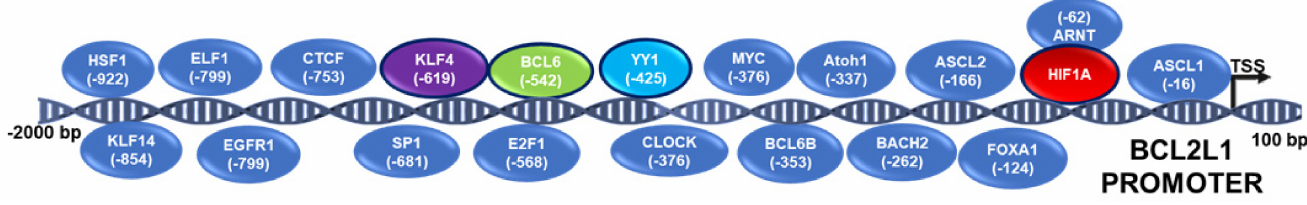
Figure 8. Scheme of transcription factors with the potential to regulate BCL-xL. Bioinformatic prediction of transcription factors potentially involved in the regulation of the BCL2L1